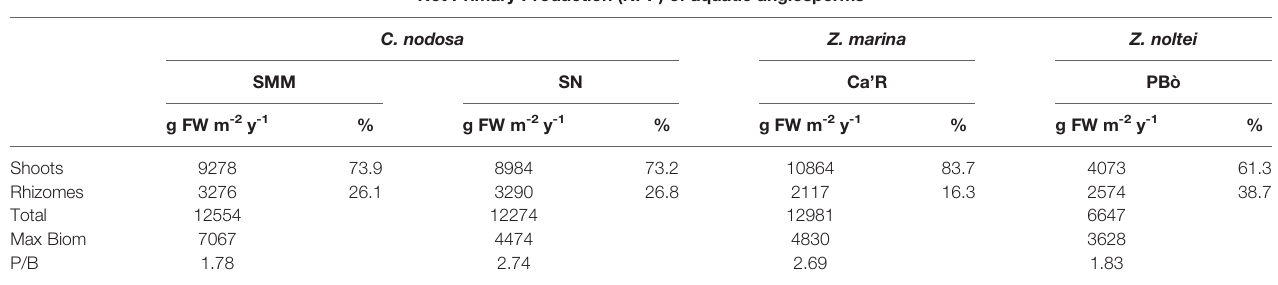
TABLE 2 | Angiosperm production.